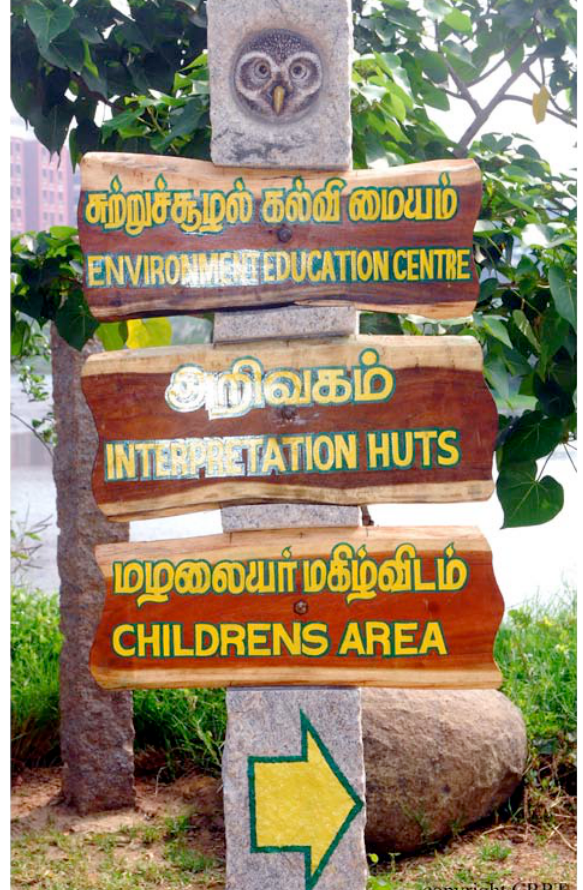
Image 7. A carved and painted Spotted Owlet Athene brama peering out of a cavity tops another rough hewn granite pillar to which planks with directional signage have been affixed. Tholkappia Poonga, Chennai.